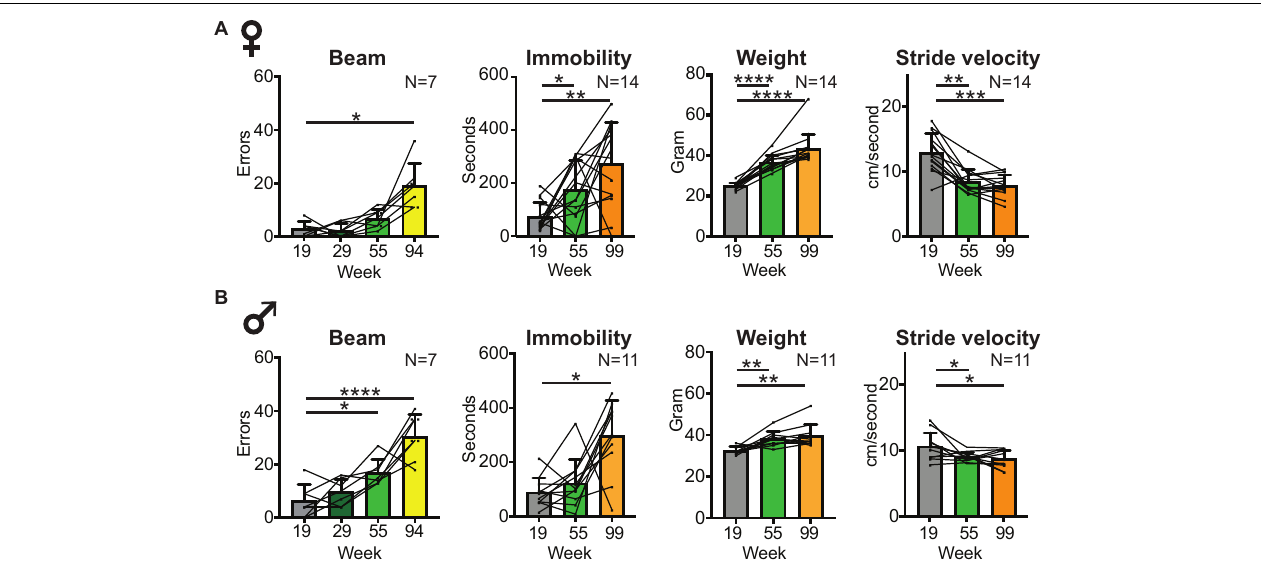
FIGURE 6 | Balance and locomotor activity decline in the middle aged to old age time range. Bar graphs of average number of slips and misses while traversing a horizontal balance beam, and average time spent immobile in an open field arena (as a measure of locomotor activity) at key time points in female (A) and male (B) cohorts. Group size and time points were dictated by the inability of mice to perform the test at later time points. Average body weight and average stride velocity of the same mice are included for full transparency. Error bars indicate standard deviation. RM-one-way ANOVA followed by Dunnett’s multiple comparison test with correction for multiple comparisons; family alpha 0.05. Statistical analyses are summarized in Supplementary Table 5 . *, **, ***, and **** represent p values of < 0.05, < 0.01, < 0.001, and < 0.0001,